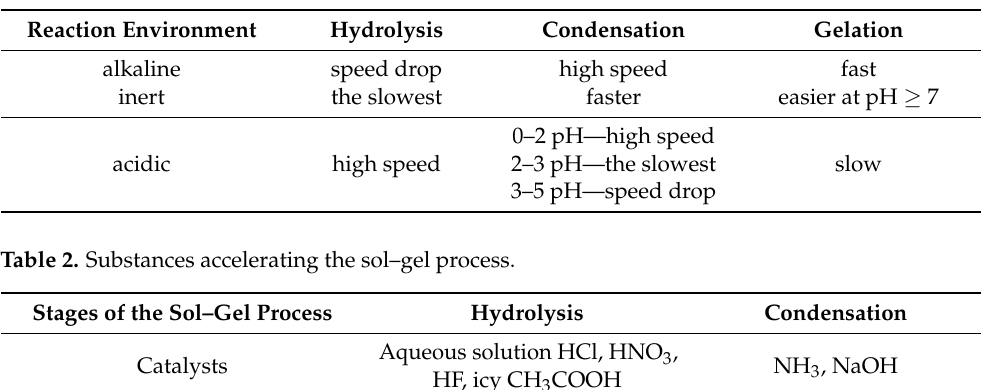
Table 1. The influence of the reaction environment on the speed of the sol–gel process.